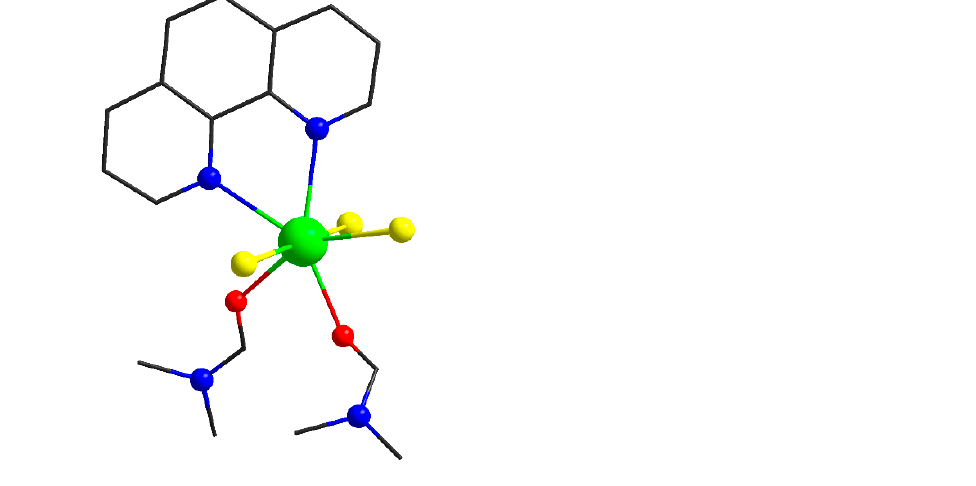
Figure A1. A molecular complex [Gd(DMF) 2 (phen)]Cl 3 . Gd atoms are green, N atoms are blue, O atoms are red, Cl atoms are yellow. H atoms are not shown.